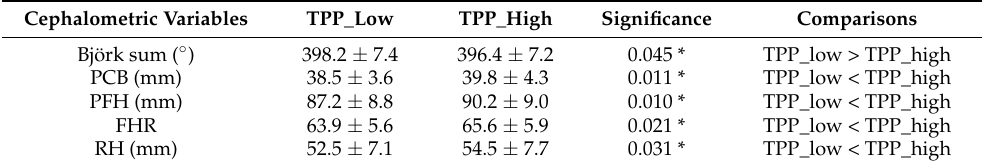
Table 4. Comparisons of cephalometric variables between TPP_low and TPP_high groups (n = 194). * Cephalometric Variables